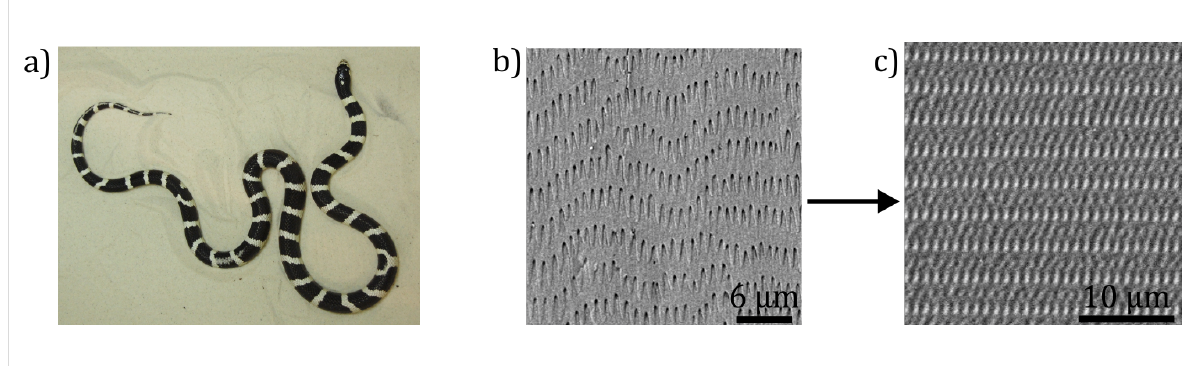
Figure 1: From the snake skin microstructure to the SIMPS. a) Photograph of the California King Snake ( Lampropeltis getula californiae ) . SEM-micro- graphs of the snake skin of a ventral scale (b) and the SIMPS made of epoxy resin (c).